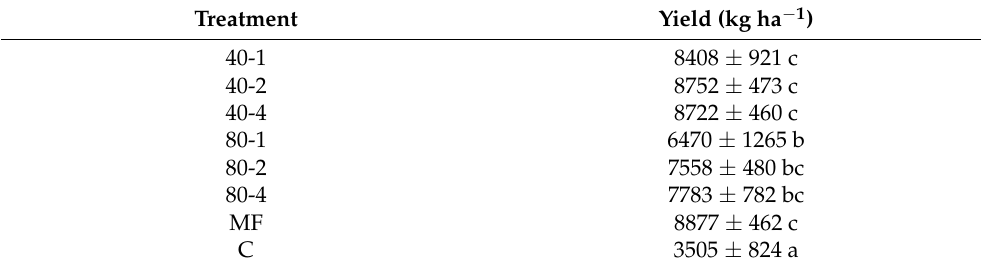
Table 8. Crop yield results (kg ha − 1 ) treatments with the same letters are not statistically different ( p < 0.001). Values are given as the mean ± standard deviation ( n = 3).